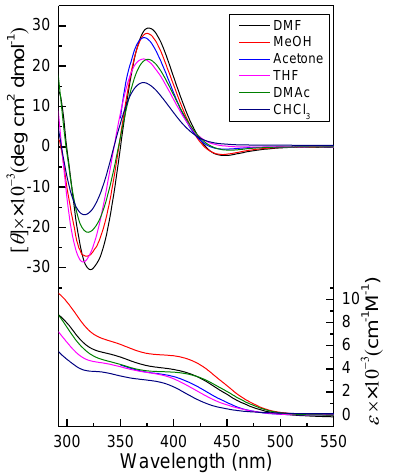
Figure 3. CD (upper) and UV-Vis (lower) spectra of PPAA-Val in variable solvents at 25 °C ( c = 1 mg/mL).